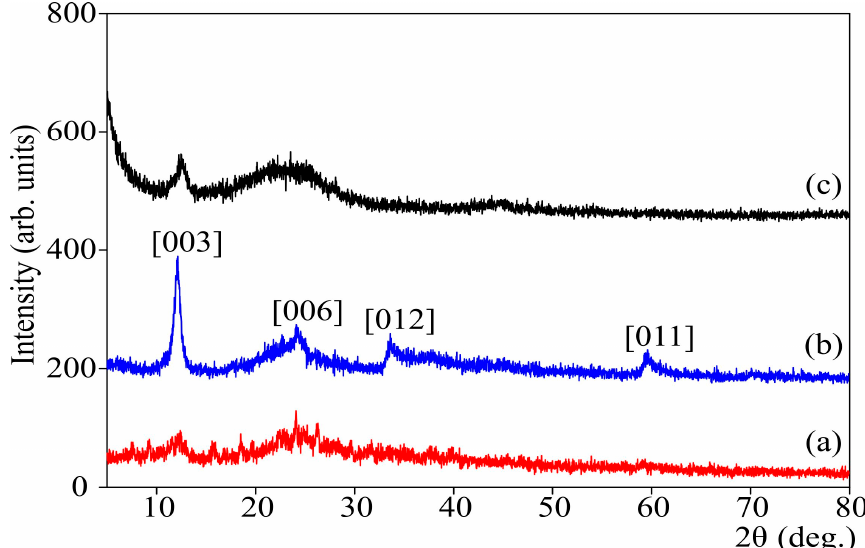
Figure 2. X-ray diffraction patterns of different samples Ni(OH) 2 /CS: ( a ) and ( b ) were obtained in different experiments; ( c ) was obtained in the presence of ACF as a substrate simultaneously with ( b ).